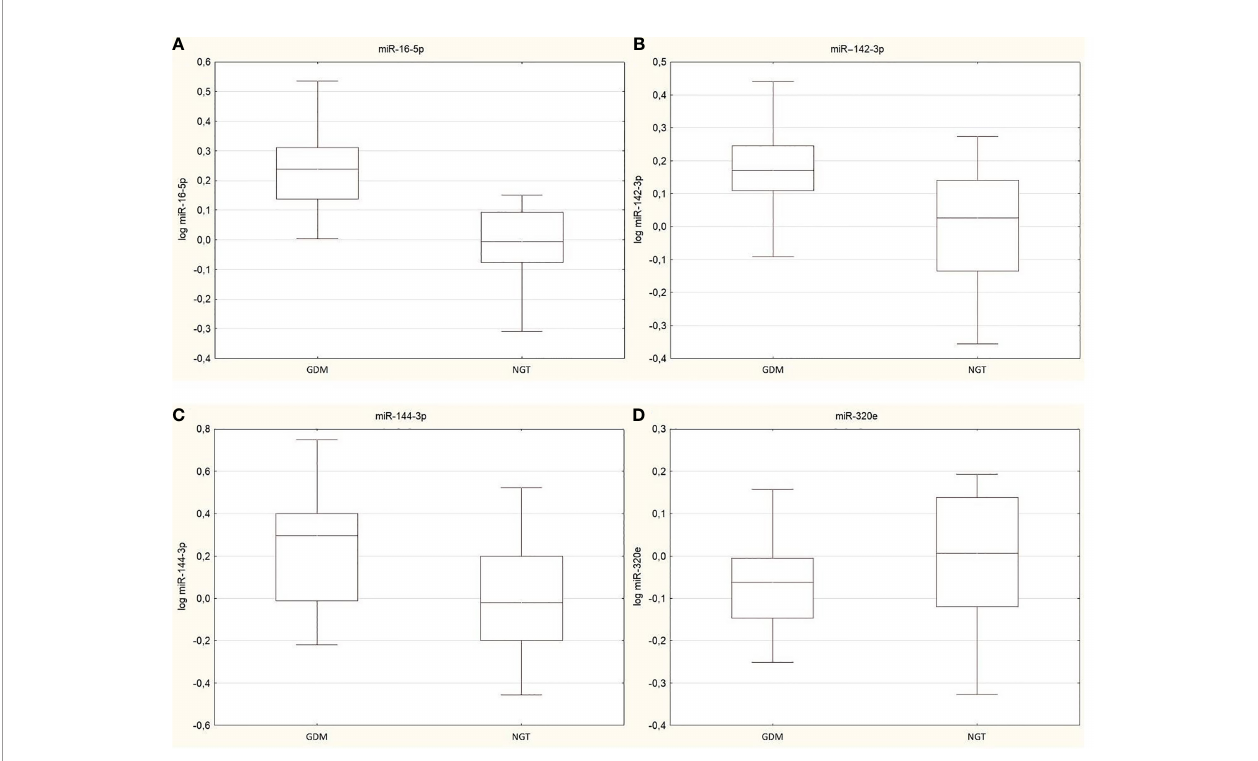
FIGURE 1 | Box plots presented changes in expression of validated miRNAs between GDM group and NGT, (A) miR-16-5p (p<0.0001), (B)/ miR-142-3p (p=0.001), (C) miR-144-3p (p=0.003) and (D) miR-320e (p=0.16). Data are presented by median indicated by line in each box and interquartile range. Maximum and minimum values are represented by